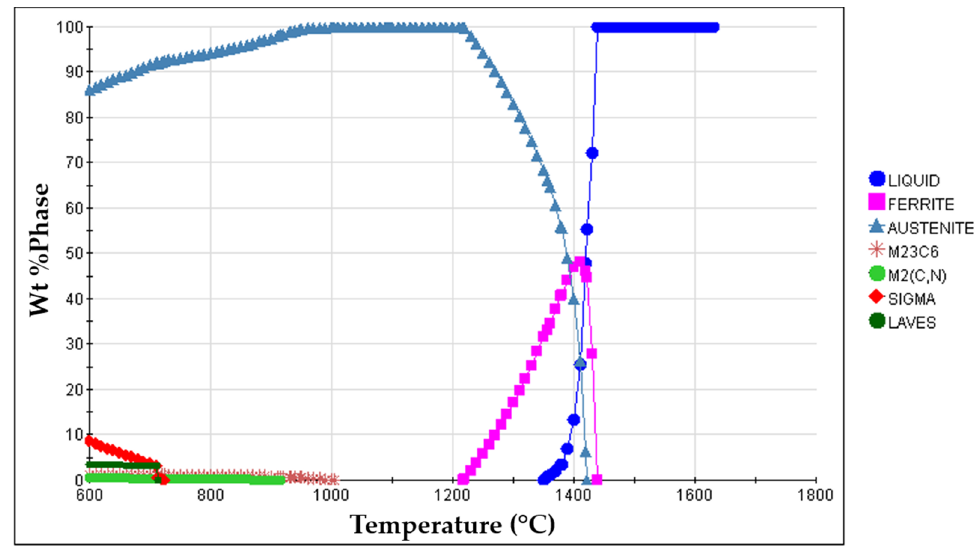
Figure 4. Equilibrium phase diagram of the GX5CrNiMo19-11-2 alloy (ISO 4991:2015) calculated with JMatPro TM v.11.2 software.